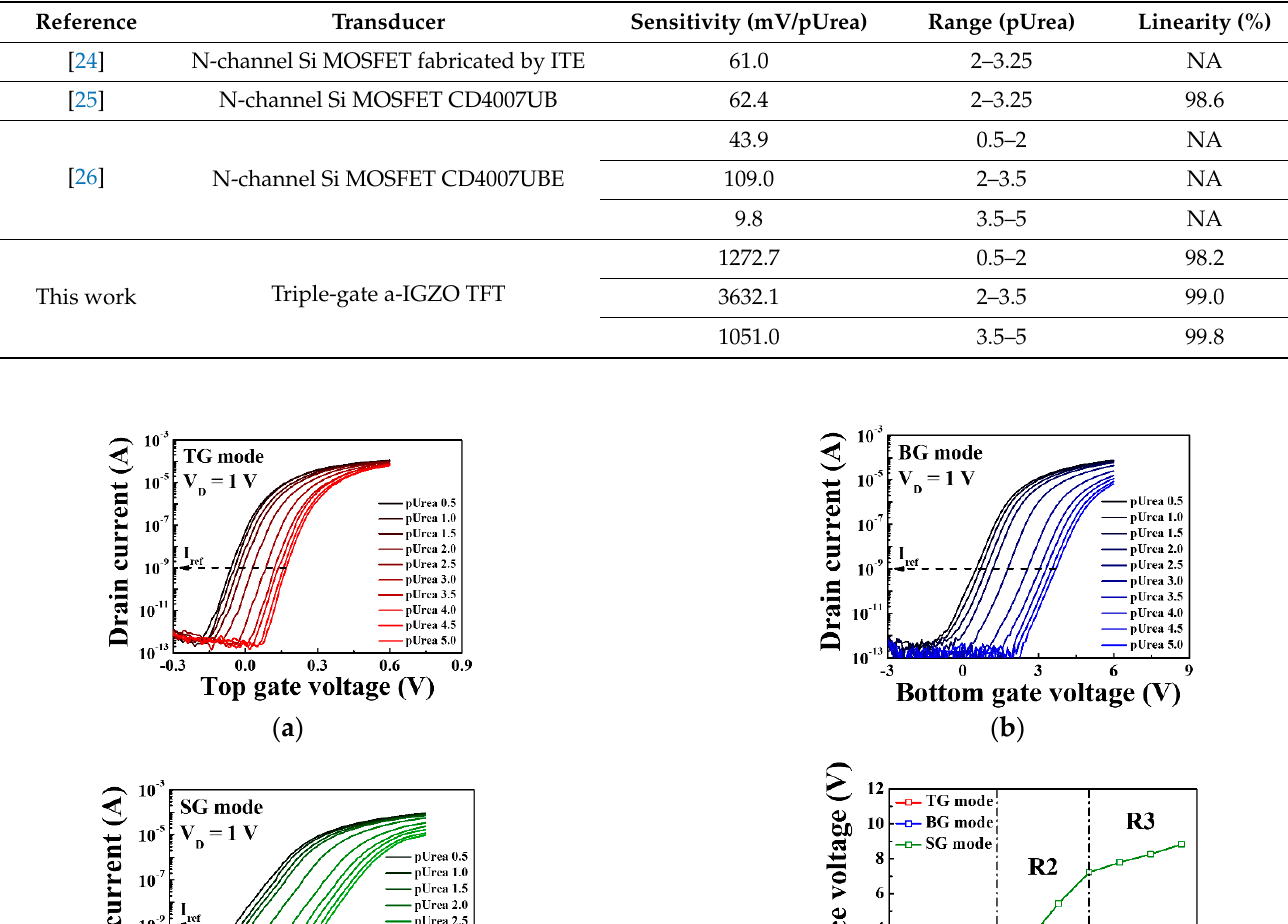
( c ) Figure 9. Transfer characteristic curves of the triple-gate a-IGZO TFT-based urea-EnFET sensor platform under the SG mode for ( a ) the interaction between the SnO 2 membrane and urea and ( b ) the interaction between urease and urea (control test). ( c ) Drain current variation over time for various urea concentrations to confirm the response time needed to reach the equilibrium state of the reaction.